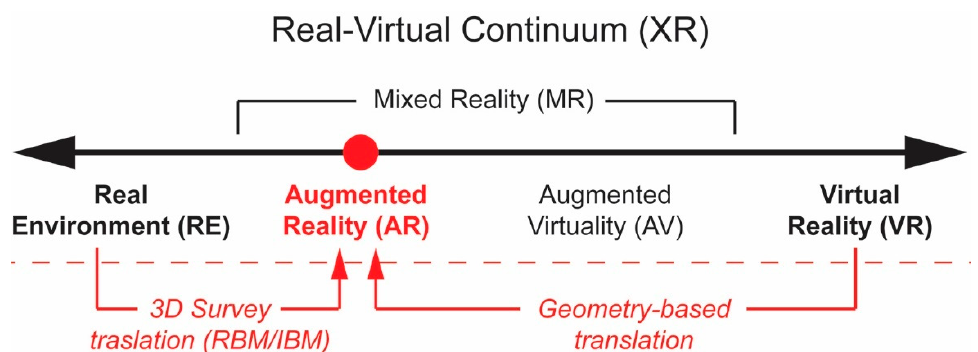
Figure 2. Milgram and Kishino’s scheme, reinterpreted and adapted for the architecture domain.